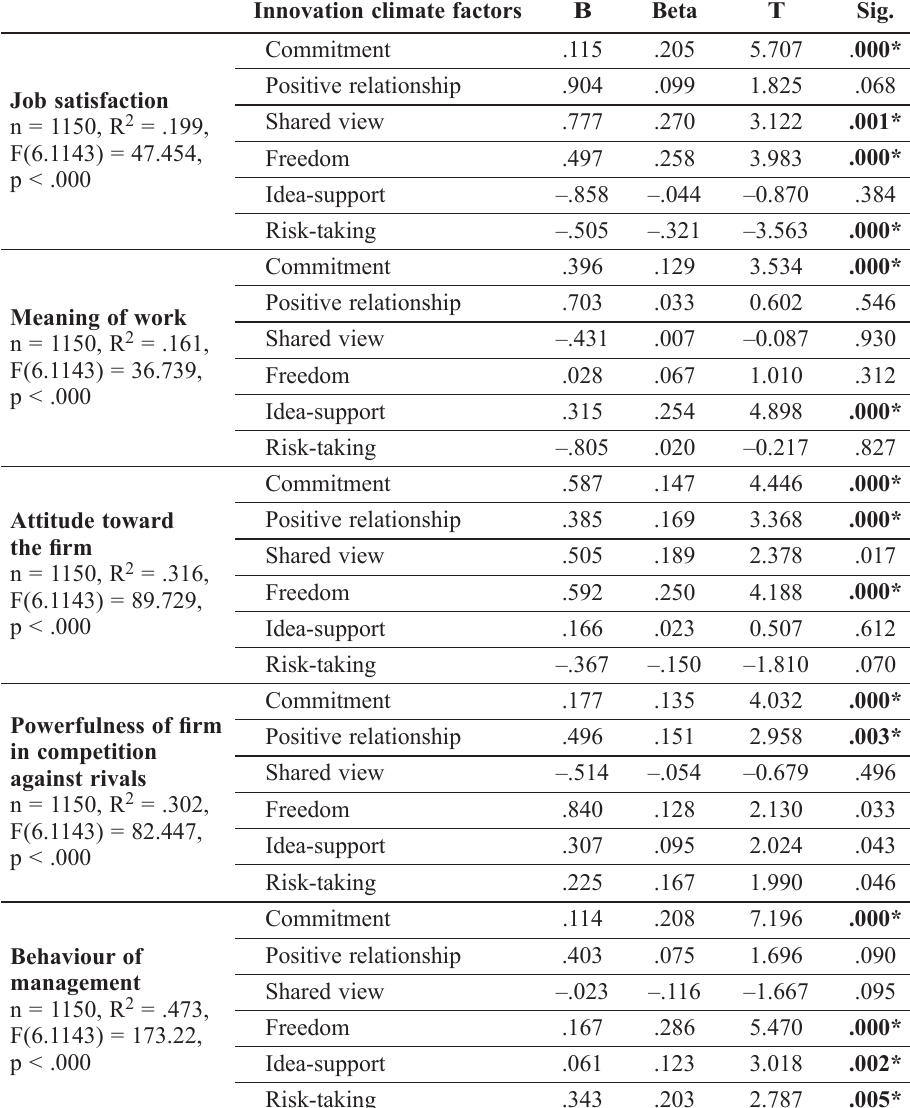
Table 1. Connections between the innovation climate and individual and organisational level factors in China (according to standardised regression coefficient Beta) Innovation climate factors B Beta T